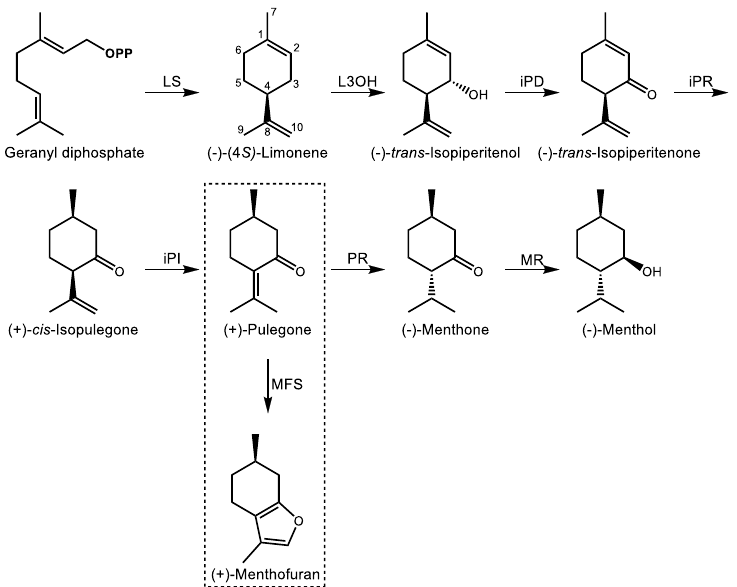
Figure 3. Steps in the biosynthesis of ( − )-menthol and related p -menthanes in peppermint ( M. x piperita) . Enzyme abbreviations are as follows; LS–( − )-limonene synthase, L3OH—( − )-limonene 3-hydroxylase, iPD—( − )- trans -isopiperitenol dehydrogenase, iPR—( − )- trans -isopiperitenone reductase, iPI—( + )- cis - isopulegone isomerase, PR—( + )-pulegone reductase, MR—( − )-menthone reductase, MFS—( + )- menthofuran synthase. OPP signifies a pyrophosphate group. The box indicates the branch pathway leading to ( +